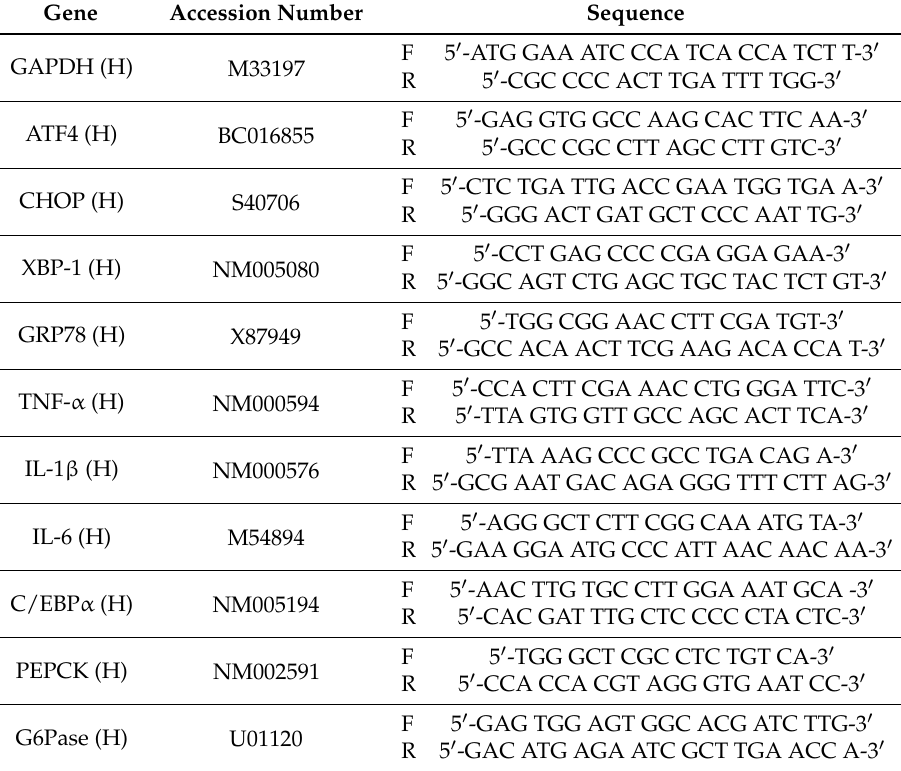
Table 1. Primer sets used for real-time